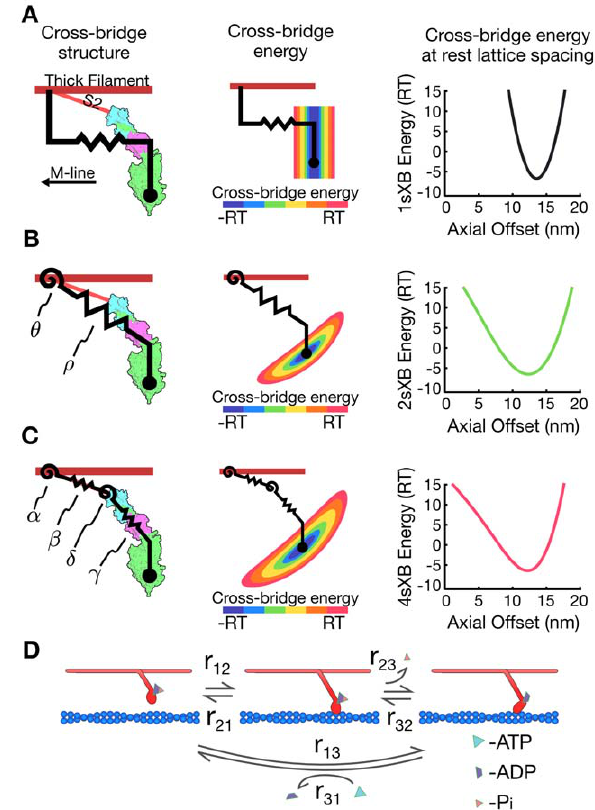
Figure 1. Cross-bridge types and kinetic scheme. (A)–(C) The three cross-bridge models, plotted against a myosin crystal structure for comparison (structure image generated from Gourinath et al. (2003) [40] with PyMol [41]). The energy landscape of each cross-bridge and the free energy at rest lattice spacing are shown adjacent to the cross- bridge schematic. (A) The 1sXB introduced in Huxley (1957) [11]. (B) The 2sXB which uses a torsional/angular spring ( h ) and an extensional spring ( r ). (C) The 4sXB with two torsional and two extensional springs. Of the 4sXB’s springs, a corresponds to the point at which the S2 region rejoins the thick filament backbone, b to the S2 region itself, d to the area linking the S2 and the light chain domains, and c to the light chain domain itself. d replicates the change in angle accompanying the power stroke by applying torque to the freely moving joint representing the converter domain. (D) The three state kinetic system. The three states represent (1) an unbound state, (2) a pre-power stroke state, and (3) a post-power stroke state. The rate of transition between states i and j is represented as r ij . The forward and reverse transition rate constants are functions of energy stored in the cross-bridge.